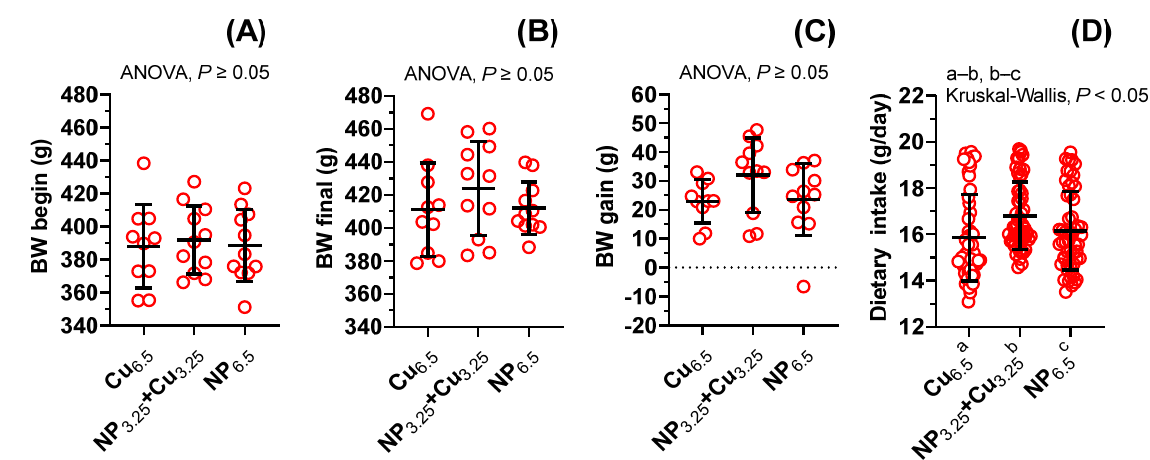
Figure 1. The influence of experimental diets on rat body weight ( A – C ), and daily feed intake ( D ). Values are expressed as means ± SD of n = 11 rats ( A – C ), and of m = 56 days of supplementation ( D ). NP 3.25 + Cu 3.25 increased by 1.06-fold the daily feed intake.